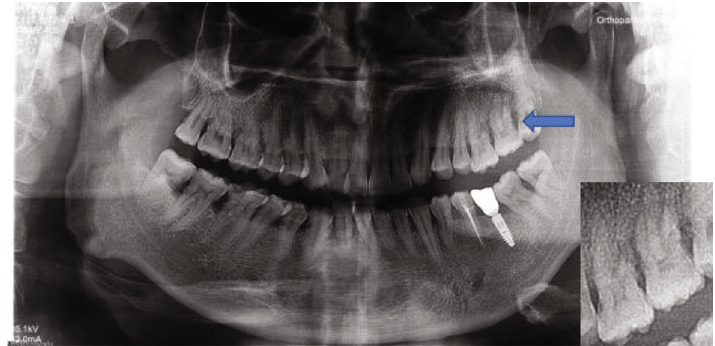
Figure 2: 26, 27 angular absorption.